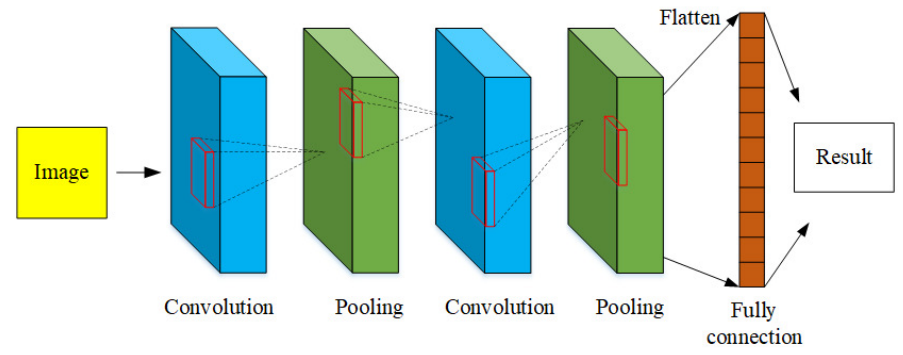
Figure 3. Structure of a standard convolutional neural network.